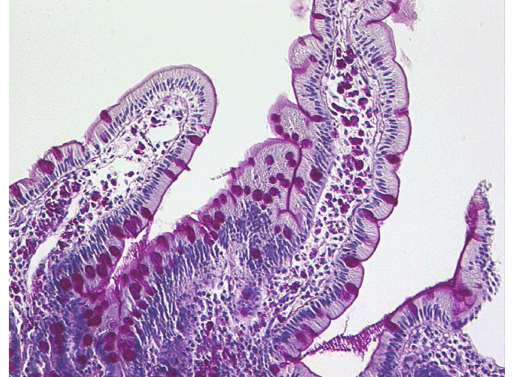
Figure 18: Whipple’s disease: partial disappearance of PAS positive macrophages from the lamina propria mucosae following the ther- apy. PAS staining. Courtesy of Jan Noˇziˇcka, MD, PhD. Reproduced with permission from Bure ˇ s and Rejchrt